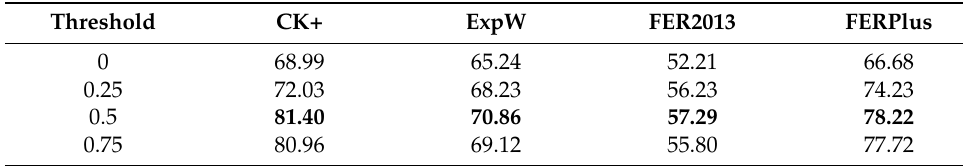
Table 4. Evaluation of the threshold for hard-negative